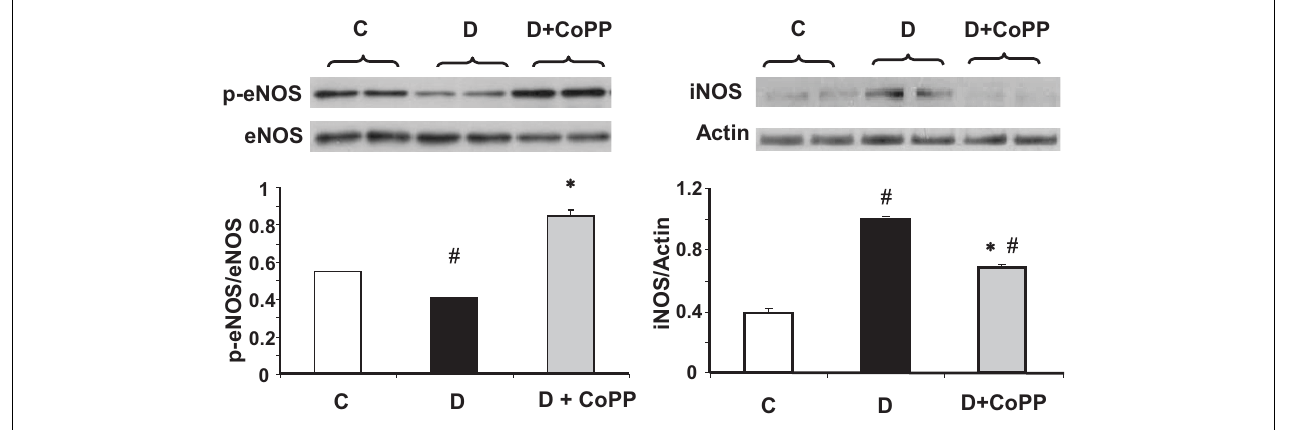
from three independent experiments is shown. Data are expressed as means ± SEM of three independent determinations # p < 0.05 vs. C; * p < 0.05 vs. D.